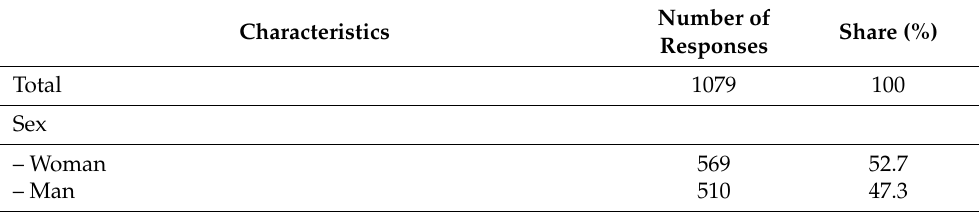
Table 3. Structure of the Research